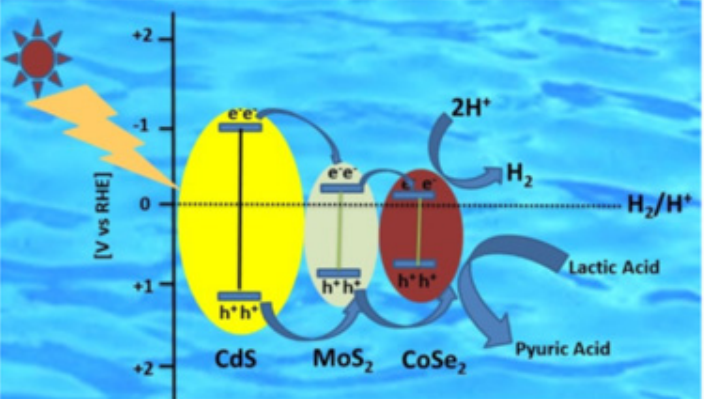
Figure 31. Schematic diagram of the mechanism of the hydrogen evolution reduction (HER) process. Reproduced with permission from [183].